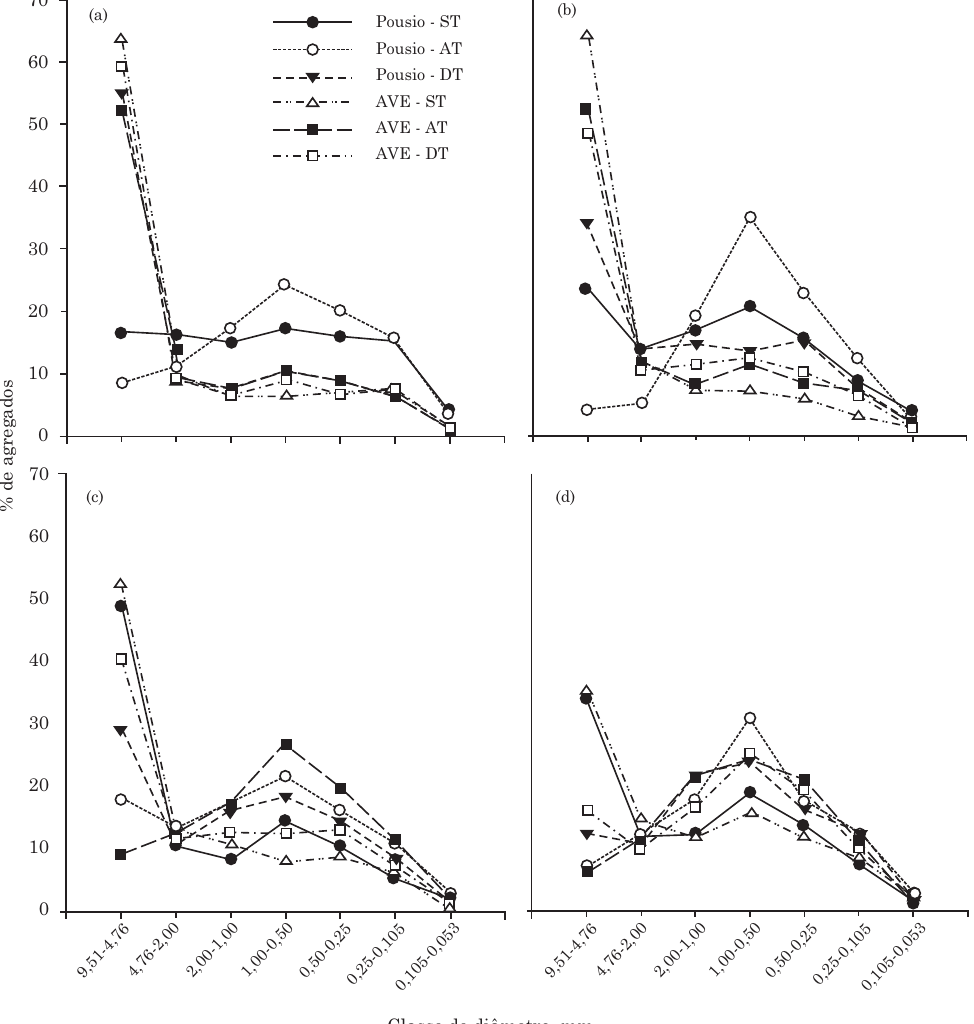
Figura 3. Distribuição de agregados por classes de tamanhos nos sistemas de manejo e nas condições de tráfego, nas profundidades 0,0-0,05 (a), 0,05-0,10 (b), 0,10-0,15 (c) e 0,15-0,20 m (d). AVE: aveia + ervilhaca; ST: sem tráfego; AT: antes do tráfego; e DT: depois do